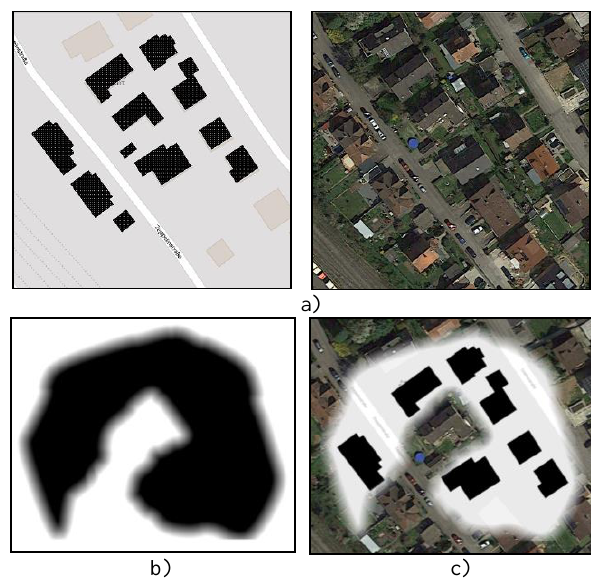
Figure 3. Map and image (© Google) representations of the test area (a), corresponding alpha blending mask (b), and combined representation with a smooth transition area between the two different privacy regions (c).